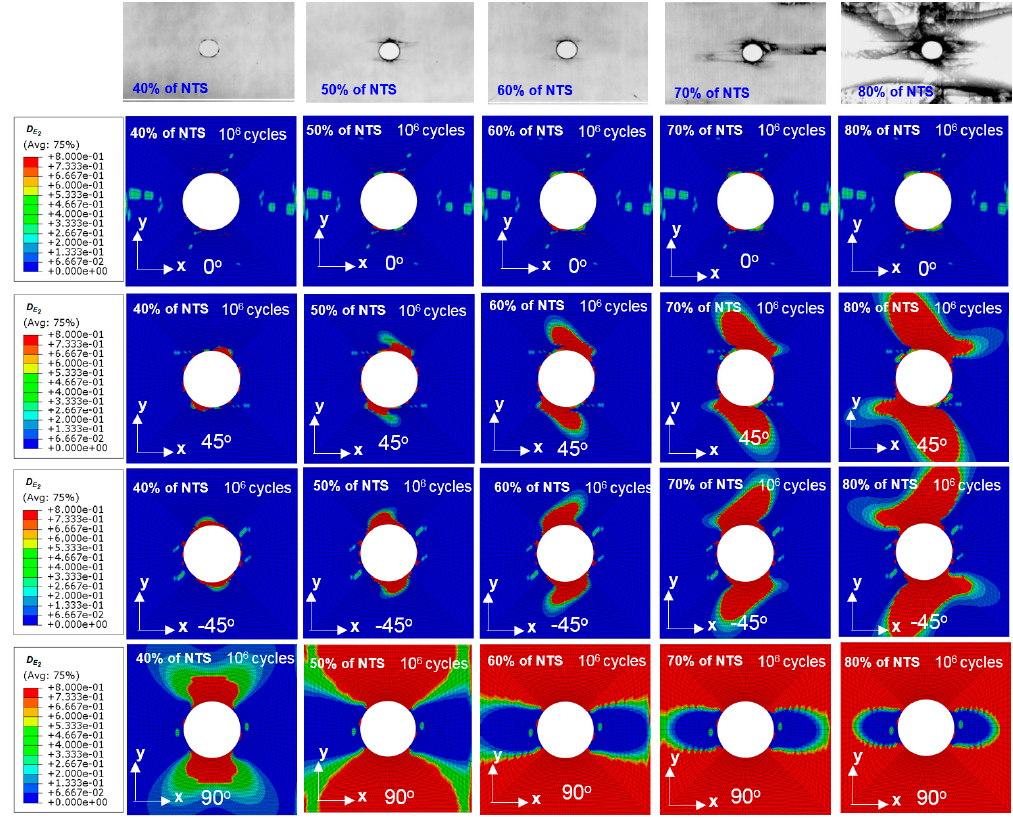
Figure 14. Reduction in stiffness E 2 in each ply of the OHT specimen after 10 6 cycles.